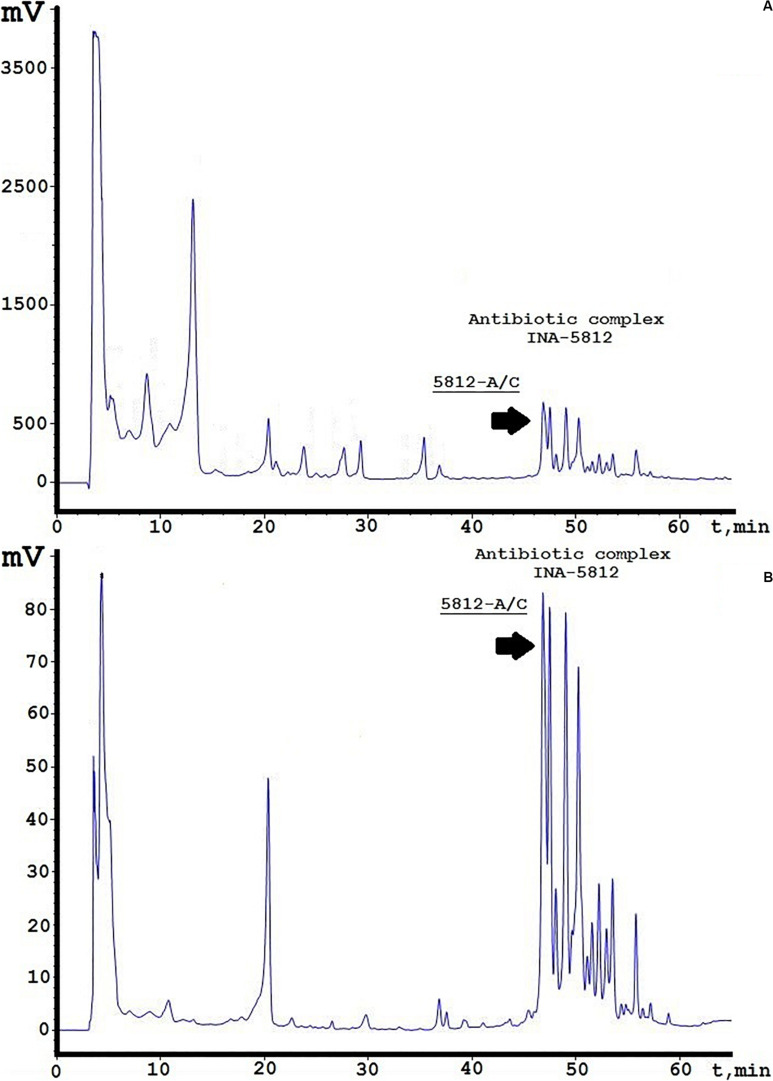
Analytical reversed-phase HPLC analysis of INA-5812 antibiotic concentrate. (A) A profile is presented at 214 nm; (B) at 364 nm. Elution peak corresponding to 5812-A/C is marked by a black arrow.